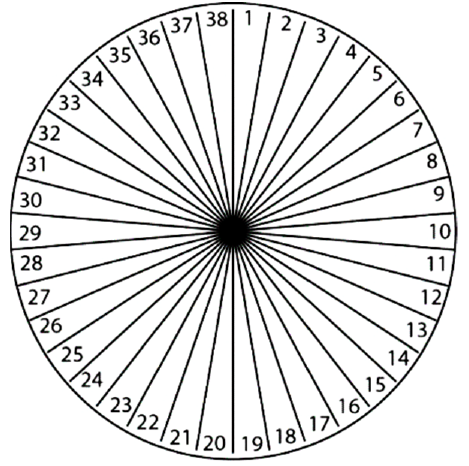
Figure 2. Reconstruction of the full ‐ annulus compressor.